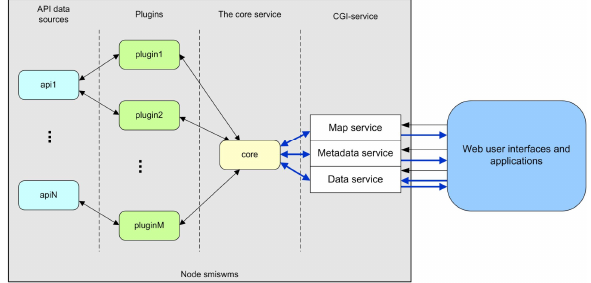
Fig.3. IRIB functional modules’ structure